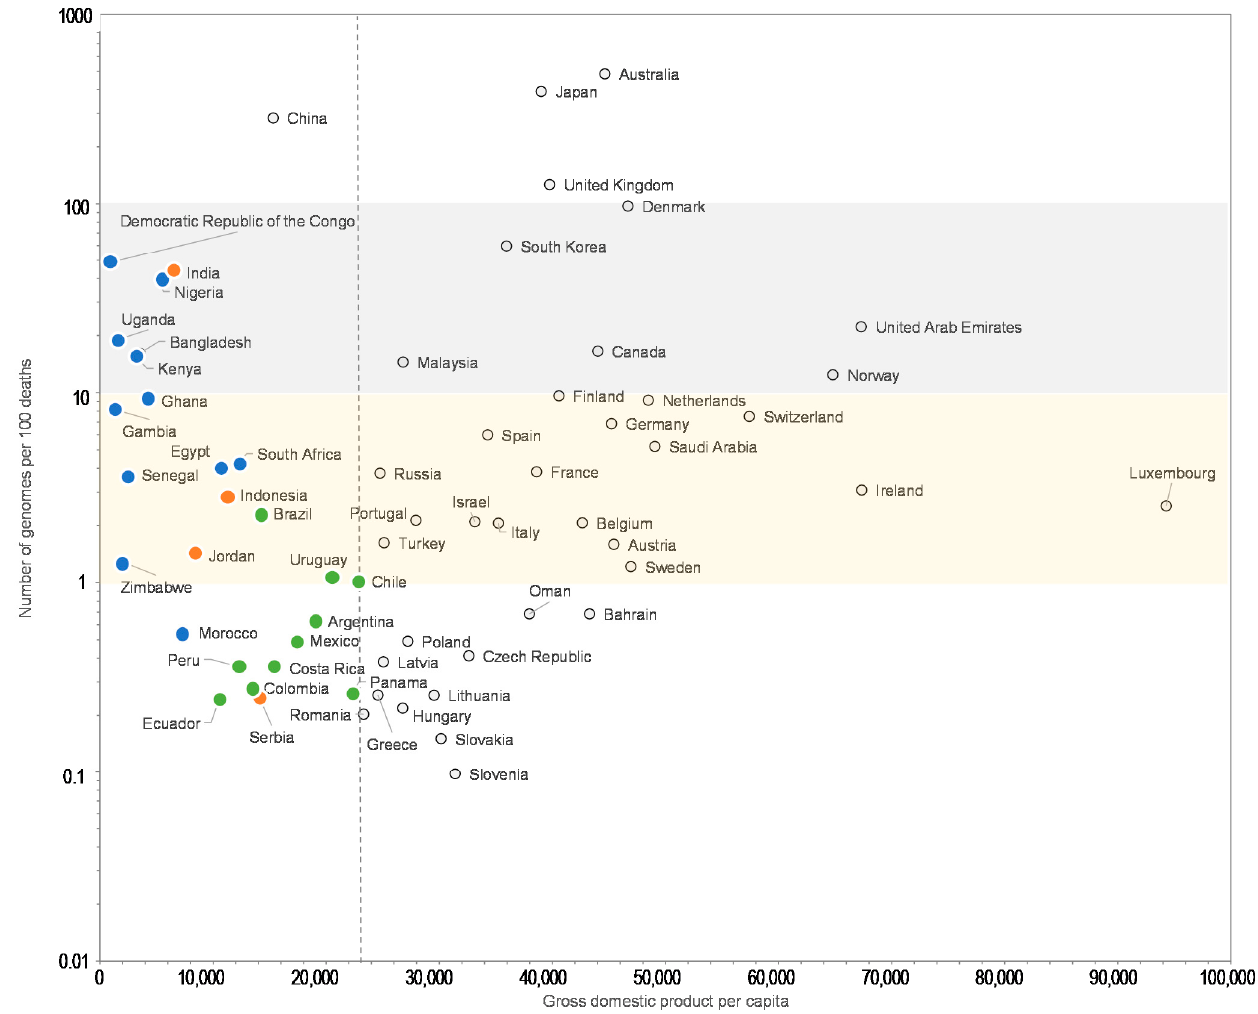
Figure 4. Number of SARS-CoV-2 genomes per 100 SARS-CoV-2-associated deaths vs. gross domestic product per capita (GDP).